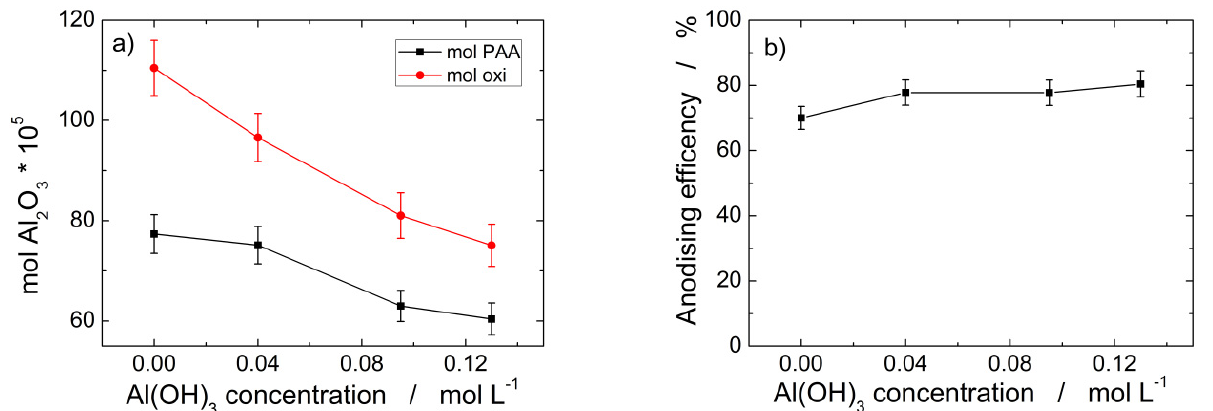
Figure 2. Aluminum anodization in mixed 0.4 M H 3 PO 4 /Al(OH) 3 electrolytes at 160 V and 0 ◦ C after 160 C cm − 2 vs. Al(OH) 3 concentration: ( a ) mol cm − 2 of Al oxidized as Al 2 O 3 and PAA moles cm − 2 formed; ( b ) anodizing % efficiency.